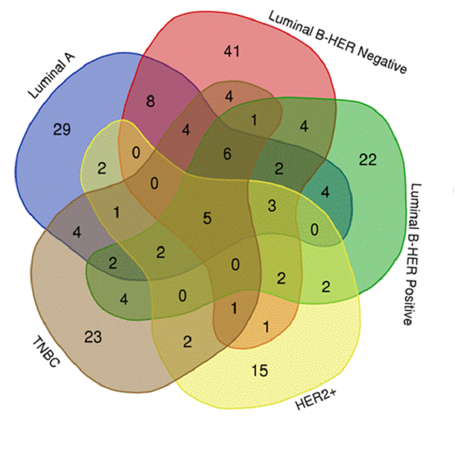
Figure 2. Venn diagram representing the number of shared proteins (biomarkers) identified in the AuNPs-protein corona formed after the interaction of AuNP (10.02 ± 0.91 nm) with serum samples belonging to the di ff erent breast cancer subtypes: luminal A (n = 11), luminal B HER2 negative (n = 10), luminal B HER2 positive (n = 7), HER2 positive (n = 6), and triple negative (n =